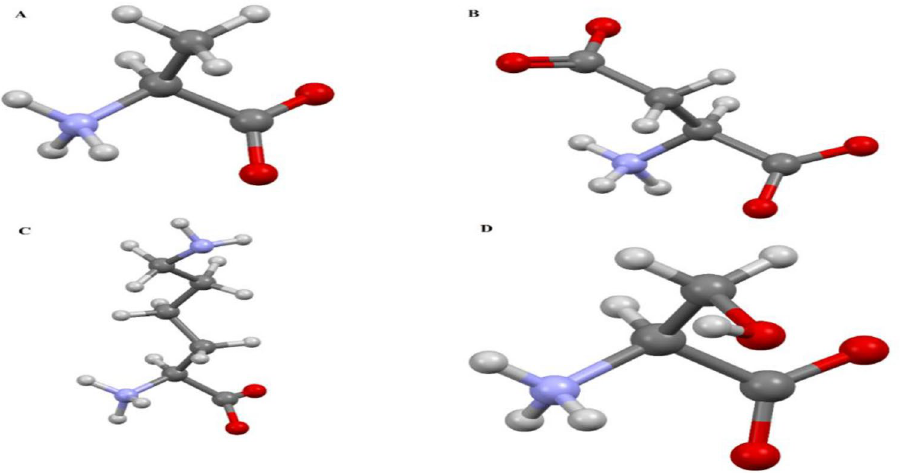
Figure 1. Ball and stick representative of the amino acids investigated in this paper. ( A ) ALA , ( B ) ASP, ( C ) LYS, and ( D ) SER [atomic symbols: N (blue), O (red), C (gray), and H